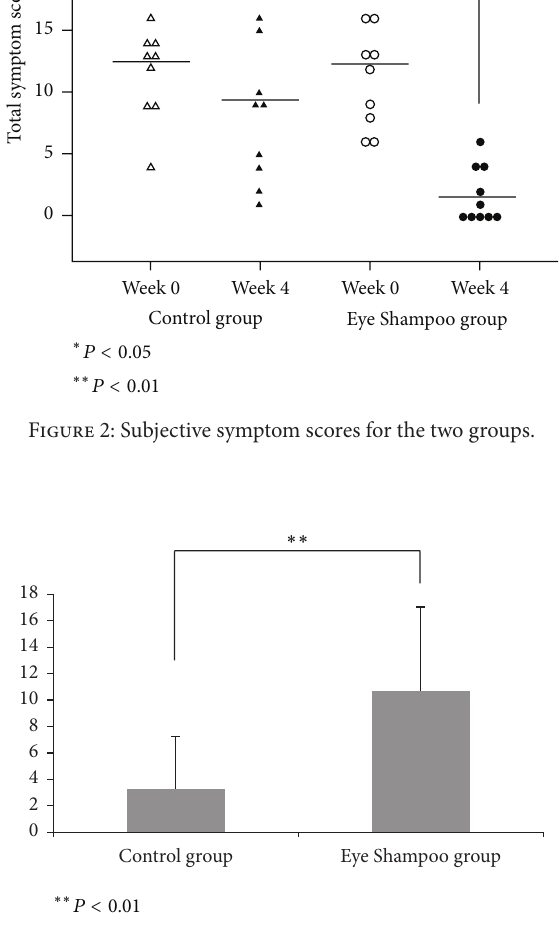
Figure 3: Variation in subjective symptom scores between the two